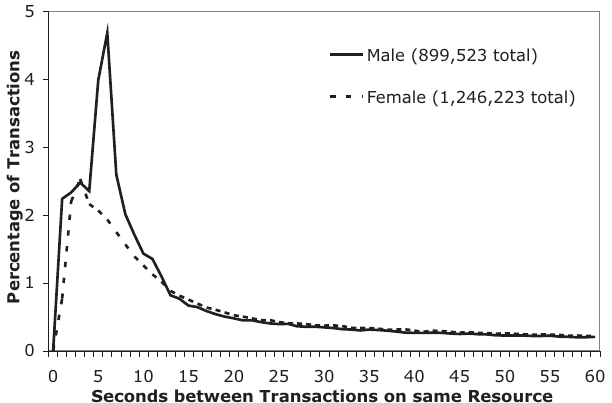
FIG. 4. Distribution of times between subsequent transactions on the same resource for transactions that occurred within less than 1 min of each other.